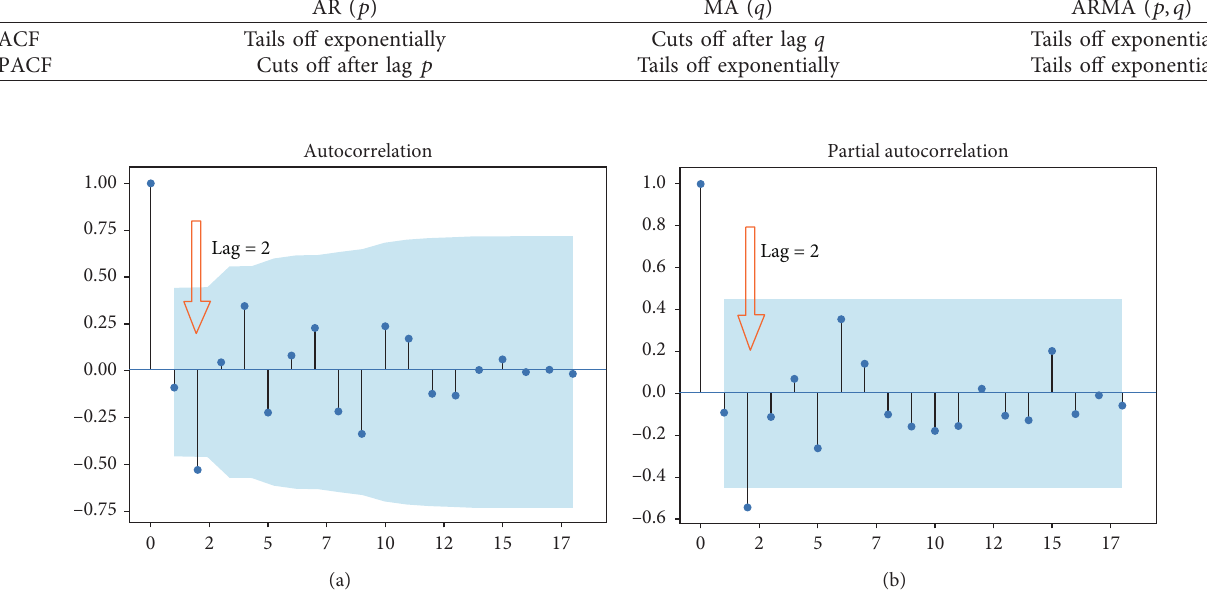
Figure 7: The correlation